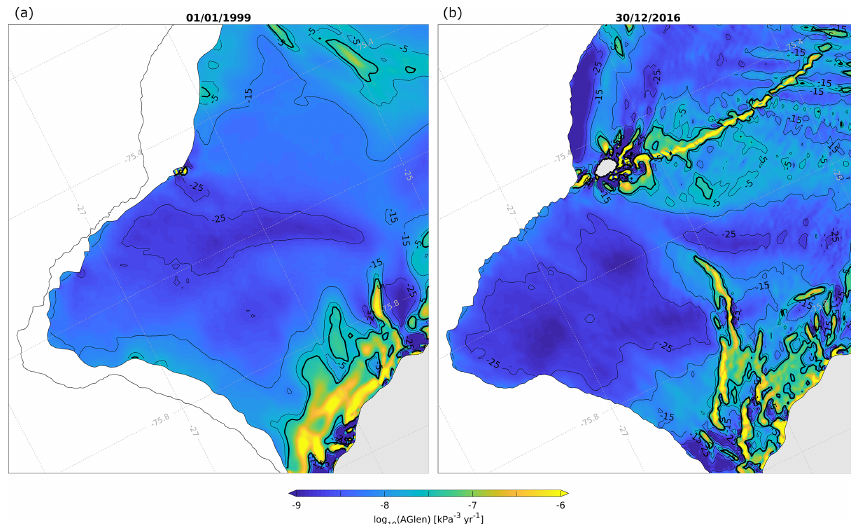
Figure A2. Examples of the rate factor A (colours) and associated “ice temperatures” in degrees Celsius (black contours) as calculated from Eq. (A1) for the Brunt Ice Shelf prior to rift formation (1 January 1999, a ) and after the initiation of Chasm 1 and Halloween Crack (30 December 2016, b ). Contours are plotted at 10 ◦ C intervals and the zero degree contour is highlighted by the thicker line. Panel (a) shows the 2016 ice shelf extent for